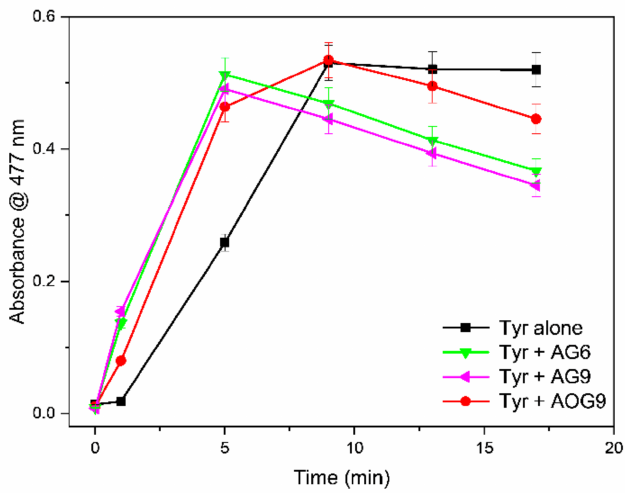
Figure 3. Influence of antamanide derivatives (0.2 µ M) on the time-course of tyrosine oxidation by the tyrosinase/O 2 oxidizing system. Data are the average of three replicates and the error is less than